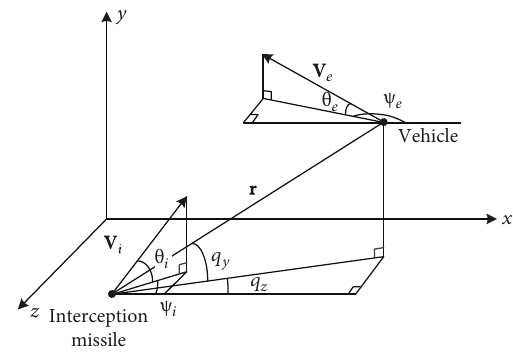
Figure 1: Relative kinetics in the attack and defense